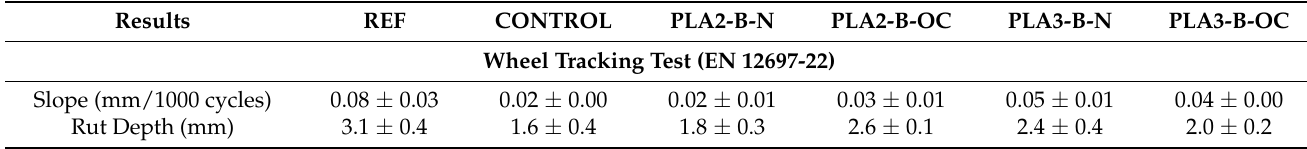
Table 10. Rutting results.